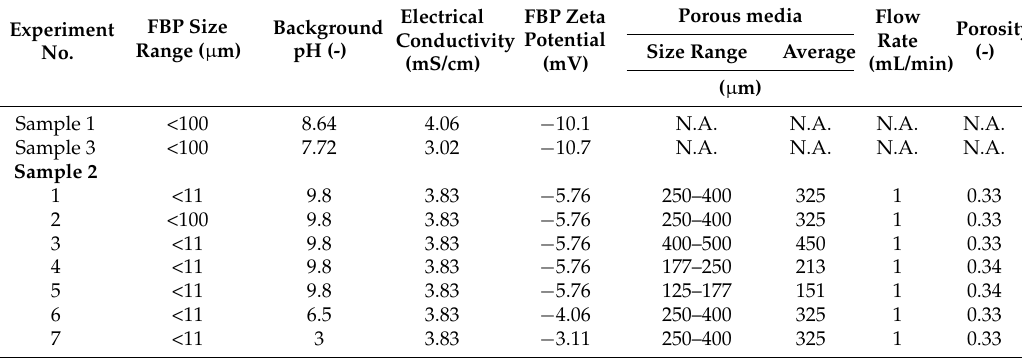
Table 1. Characteristics of fire born particles (FBPs) in extinguishing water and column experiment